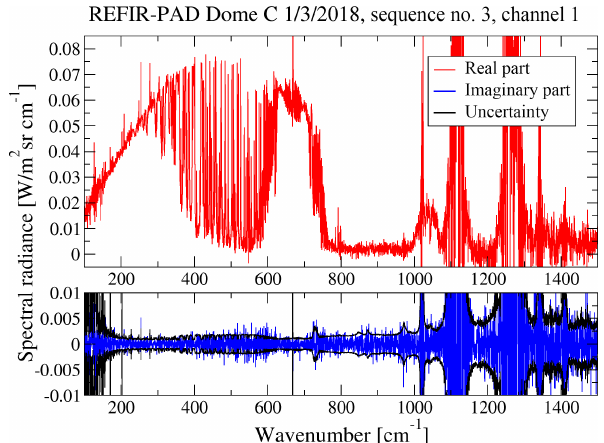
Figure 12. Real (red line), imaginary (blue line), and noise (black) for a typical zenith-looking calibrated spectrum.